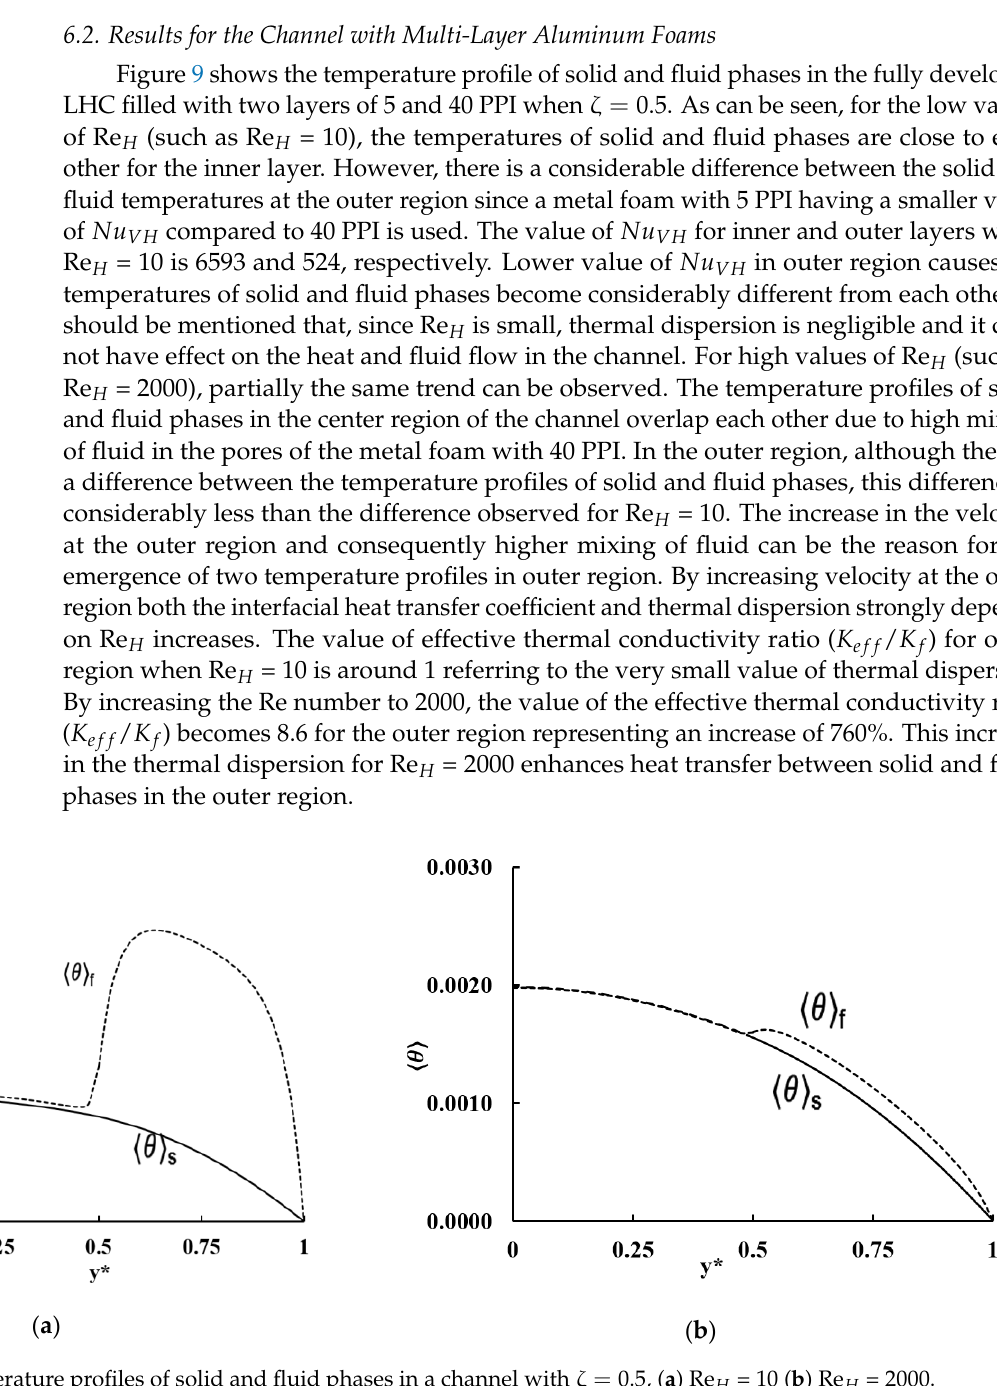
Figure 9. Temperature profiles of solid and fluid phases in a channel with ζ = 0.5, ( a ) Re 𝐻 = 10 ( b ) Re 𝐻 = 2000.